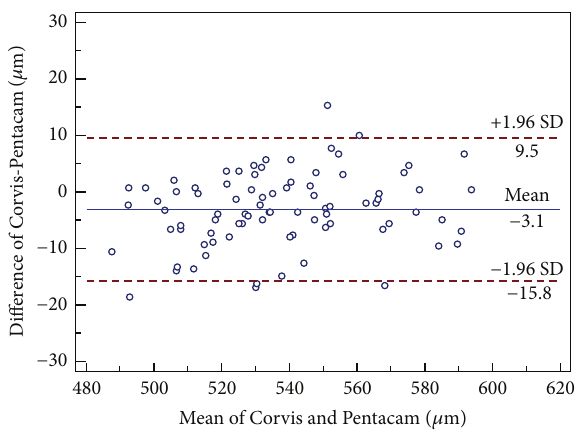
Figure 1: Bland-Altman plot demonstrating central corneal thick- ness measurements obtained using corneal dynamic Scheimpflug analyzer Corvis ST and Pentacam rotating Scheimpflug system against the mean values for both devices. The 95% limits of agreement are represented as the upper and lower lines.